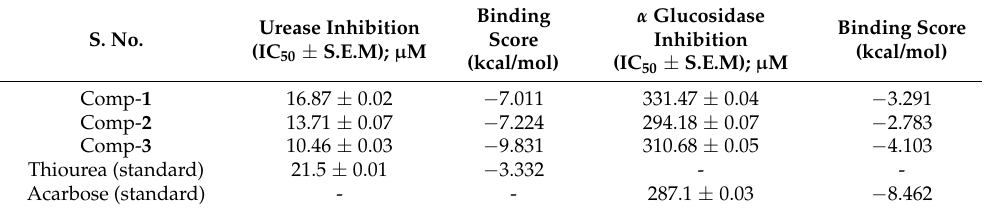
Table 3. Enzyme inhibition activity (i.e., urease and α glucosidase) and binding score for acrylic acid derivatives (compound 1 – 3